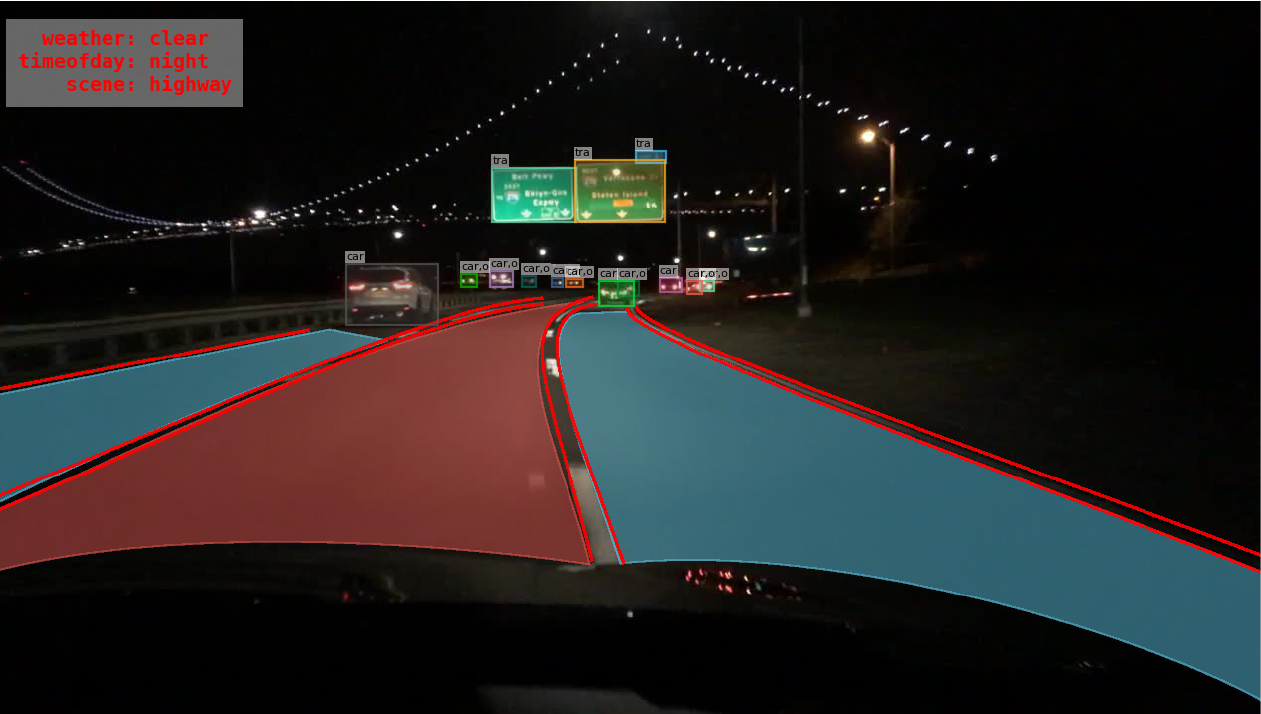
Figure 9. An example of a BDD100K labelling.